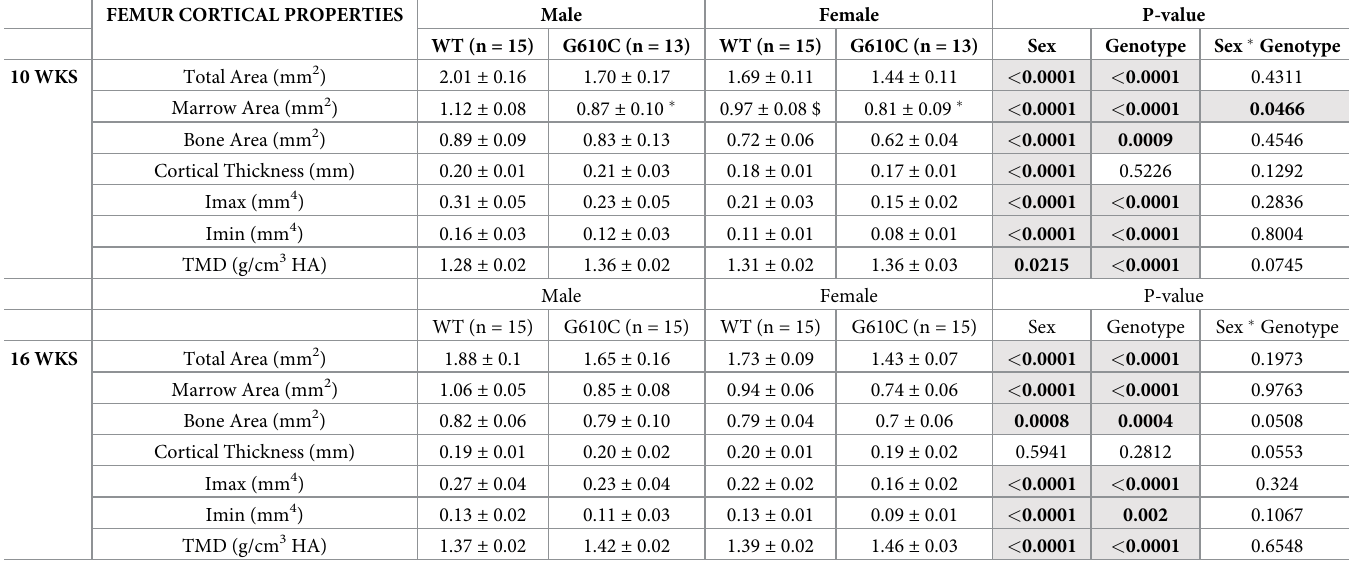
Table 3. Femur cortical properties at 10 and 16 weeks, with p-values from 2-way ANOVA. FEMUR CORTICAL